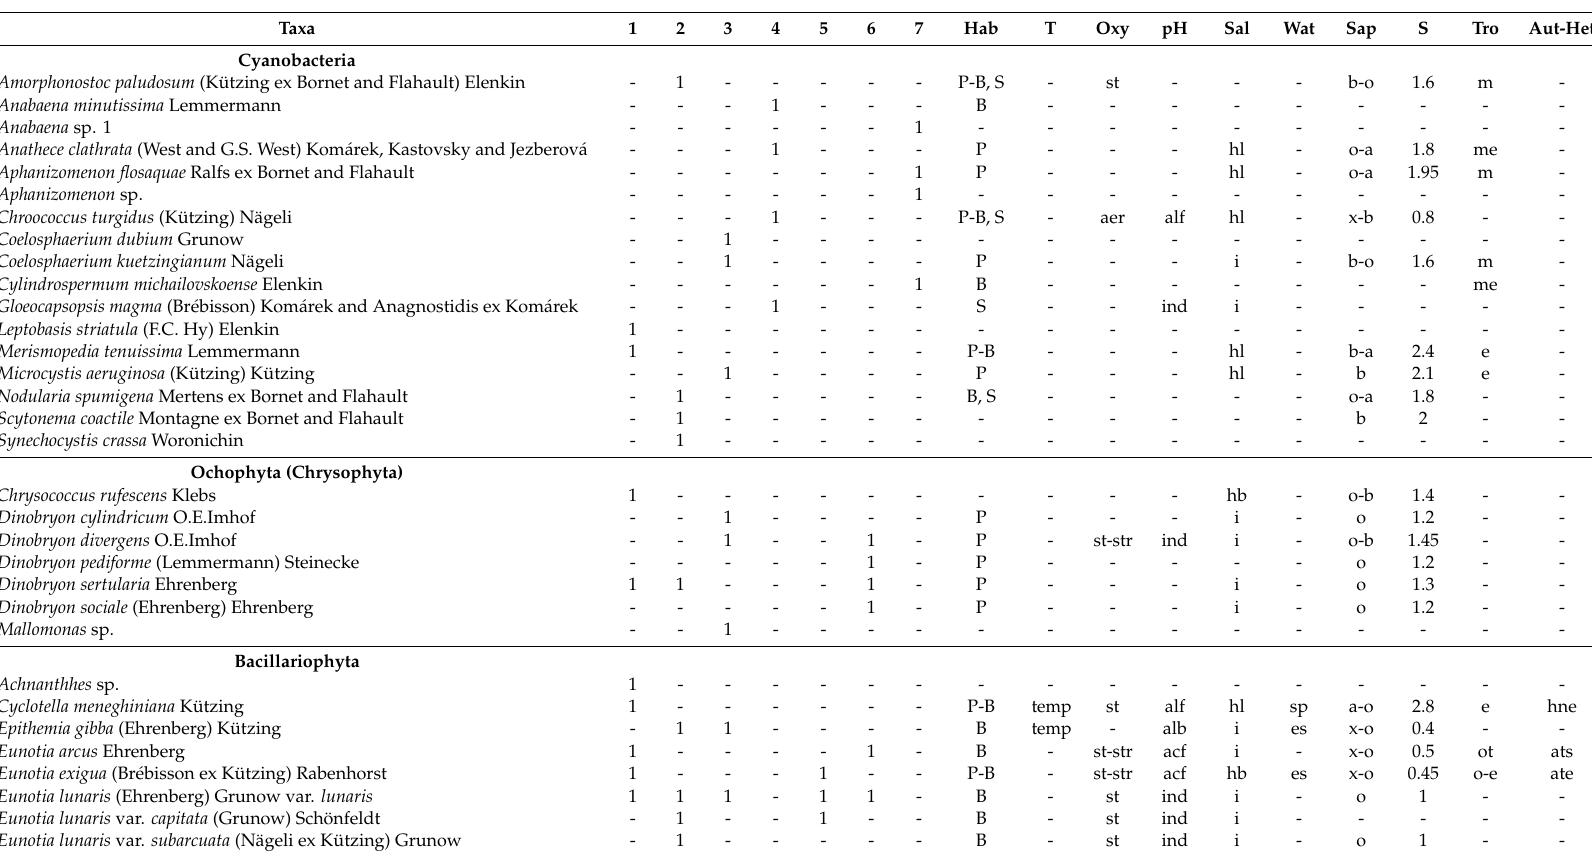
Table 2. Species composition of algae and cyanobacteria in the studied sites of the bogs of the Ershov oil field in the Vakh River basin of the Khanty-Mansiysk Autonomous Okrug–Yugra